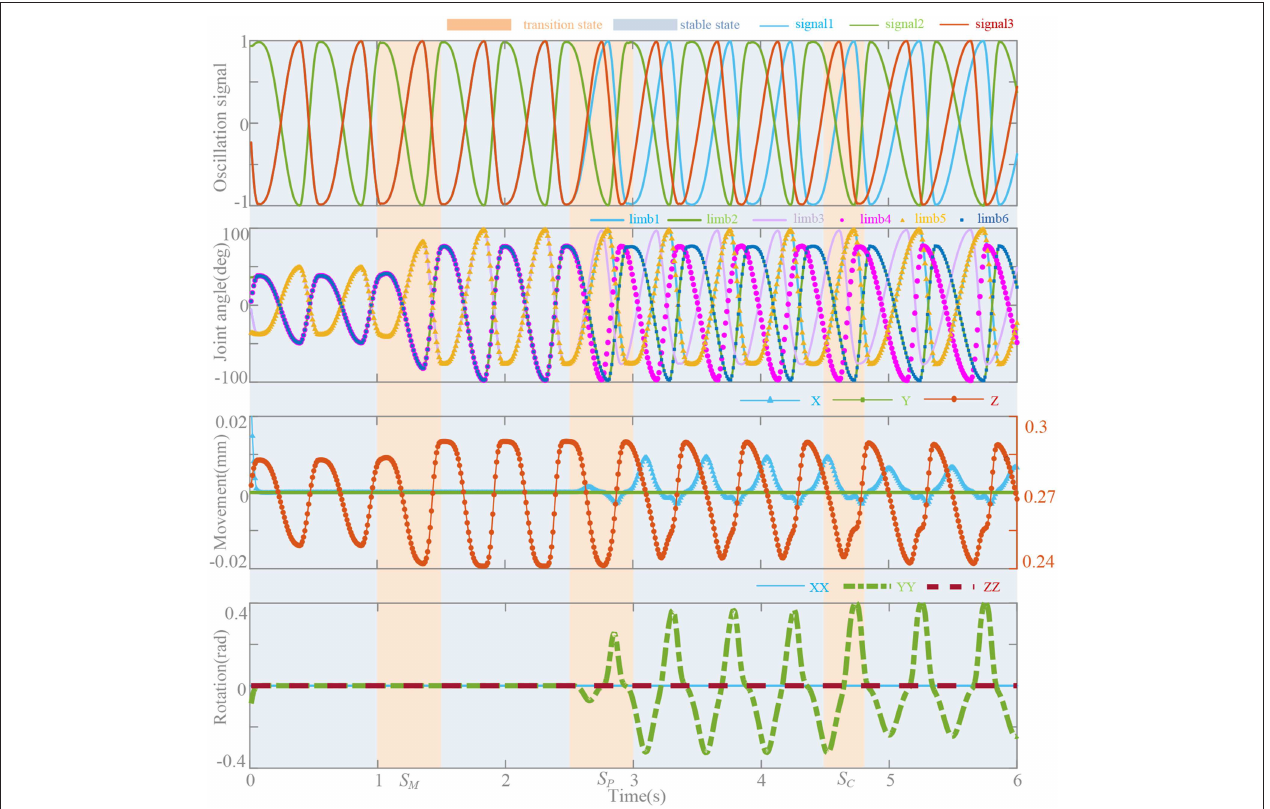
FIGURE 10 | Oscillation signals, joint angles, and locomotion trajectories. T = 0.5s, k ( t ) = 5, ψ = [0, 0.5, 0, 0.5, 0, 0.5], and ρ = [1/4, 3/4, 1/4, 3/4, 1/4, 3/4]. Magnitude transition ( S M ): movement Z (0.25, 0.28mm) → (0.241, 0.292mm). Phase transition ( S P ): ψ → [0, 0.5, 0.2, 0.7, 0, 0.5]. Coupling strength transition ( S C ), k ( t ) = 5 → k ( t ) = k e ( t